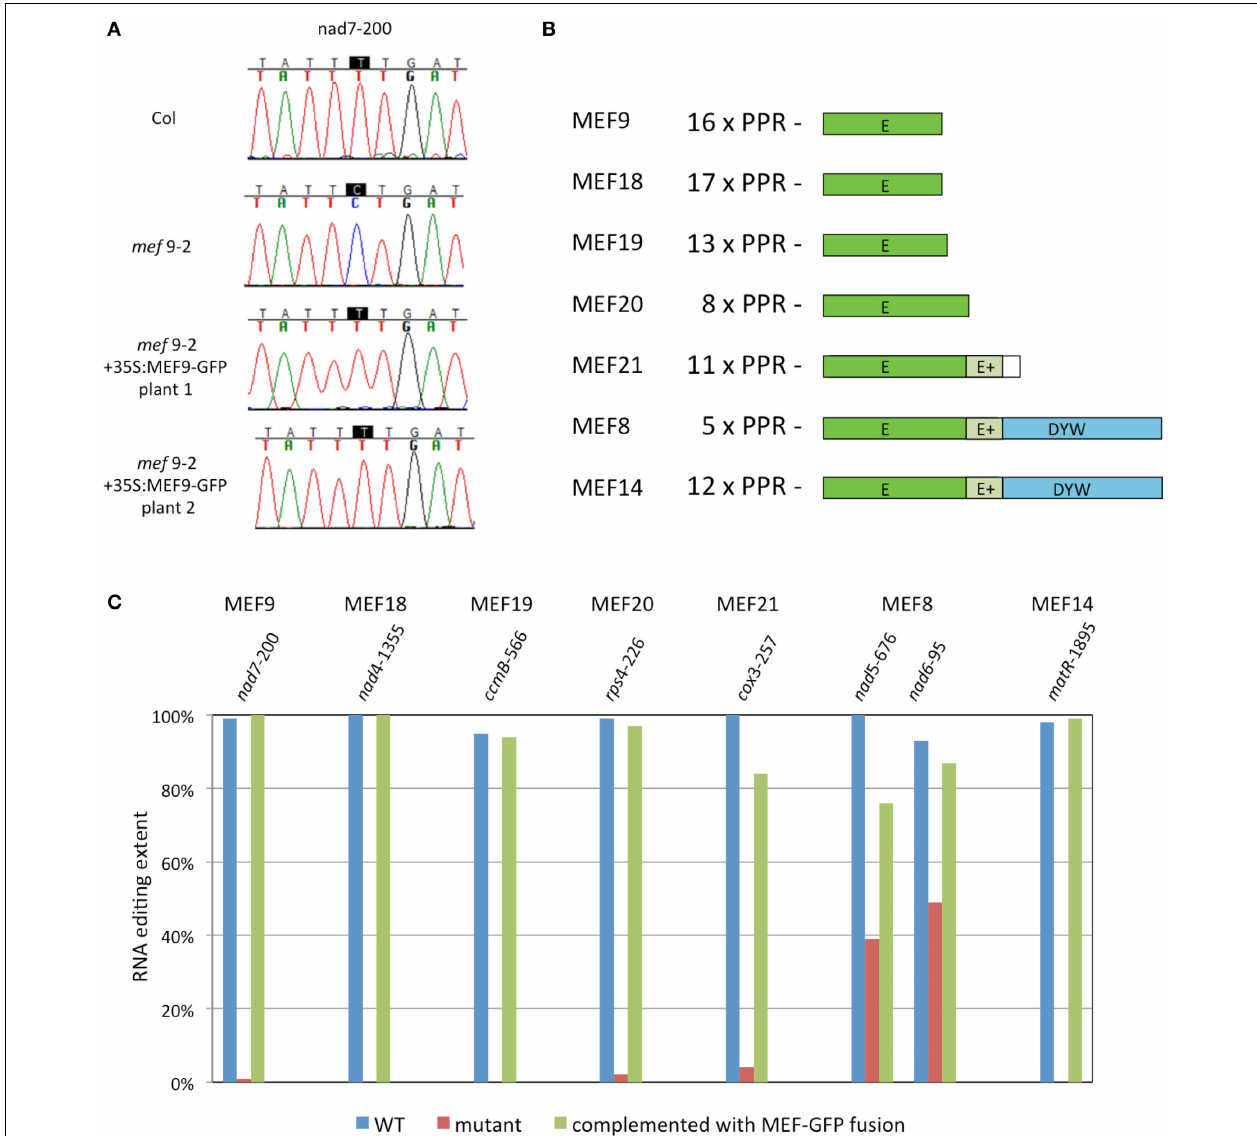
FIGURE 1 | RNA editing specific PPR-proteins terminating with E- or DYW-domains tolerate an additional protein tag. (A) Analysis of MEF9 is shown as a representative example. The single target site of MEF9 in the mitochondrial mRNA coding for subunit 7 of the respiratory chain complex I is nearly completely edited to U in wild type Arabidopsis thaliana plants of the Columbia ecotype (Col; Takenaka, 2010). In the mef9-2 mutant plant, RNA editing at nucleotide nad7 -200 (counted from the A in the AUG translational start codon) is below the background threshold of 10%. The chimeric protein of MEF9 with GFP attached to the C-terminus of the E domain fully recovers editing at this site (Plants 1 and 2). Color traces are: G, black; A, green; T, red; C, blue. (B) Structure of the PPR RNA editing proteins analyzed as chimeric MEF-GFP proteins. The number of the PPR elements are given and the approximate lengths of the E domains are depicted. Several proteins contain